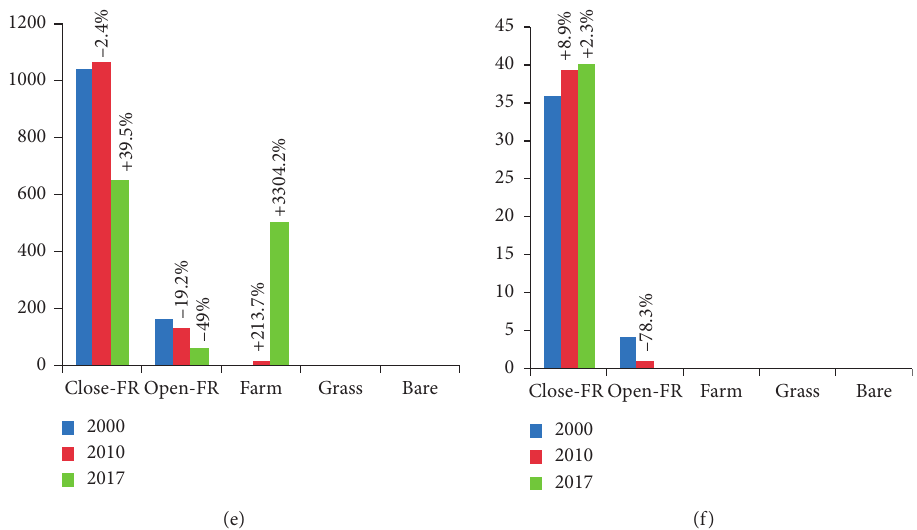
Figure 10: Forest land cover trends (% increase/decrease) for six FRs based on road proximity: (a) Muro FR; (b) Tano Suhien FR; (c) Tano Suraw FR; (d) Krokosua FR; (e) Sui River FR; and (f) Suhuma FR.